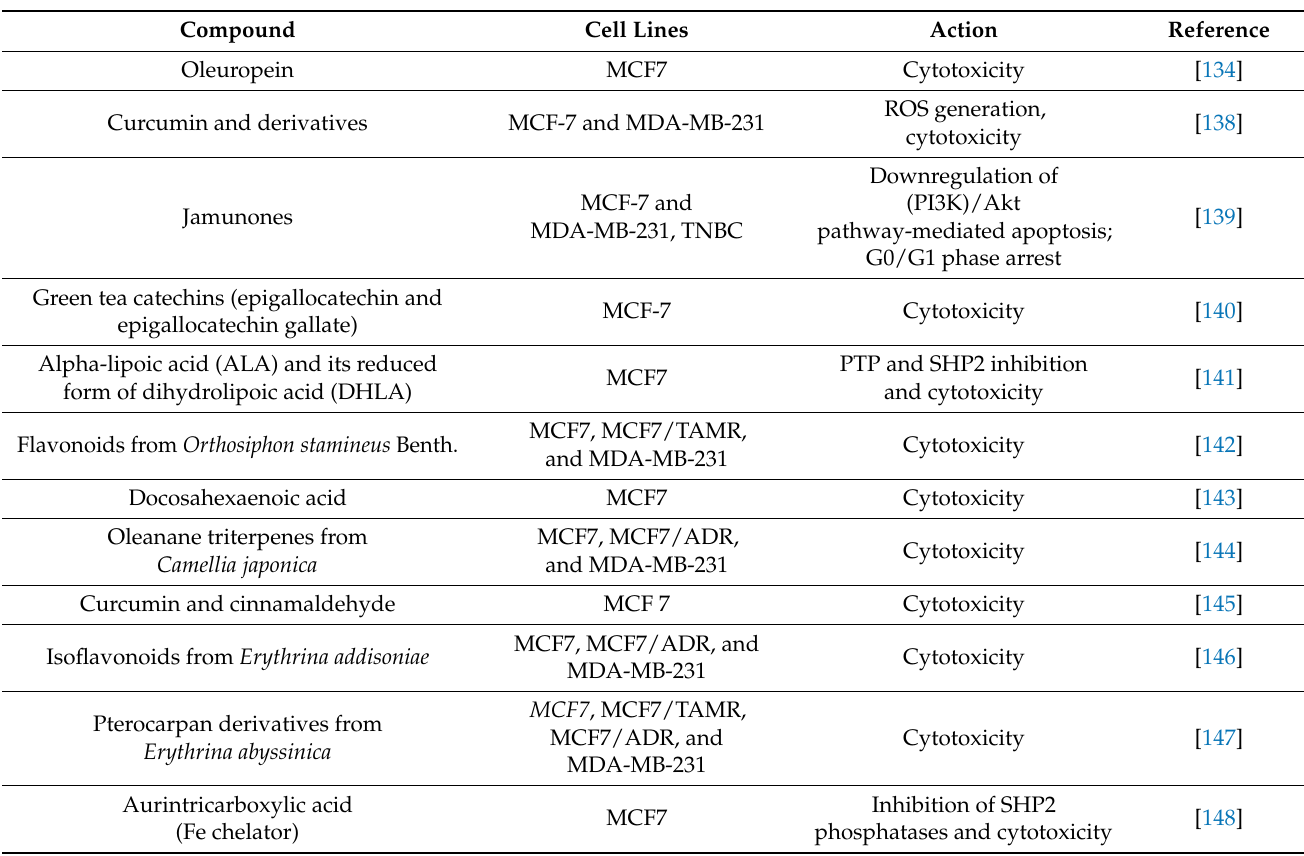
Table 2. Some recently reported PTP1B inhibitors with promising anticancer activity against breast